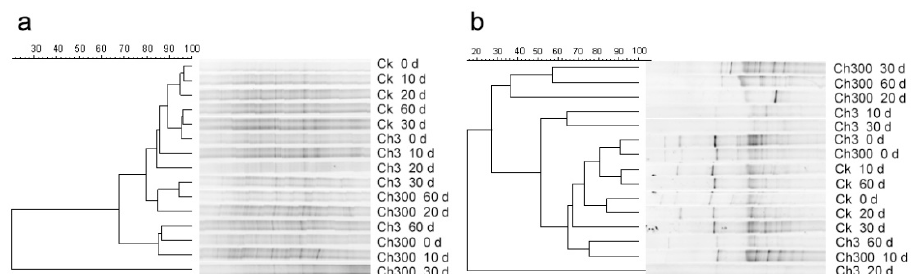
Table 3. Analysis and comparison of the DGGE fingerprints.